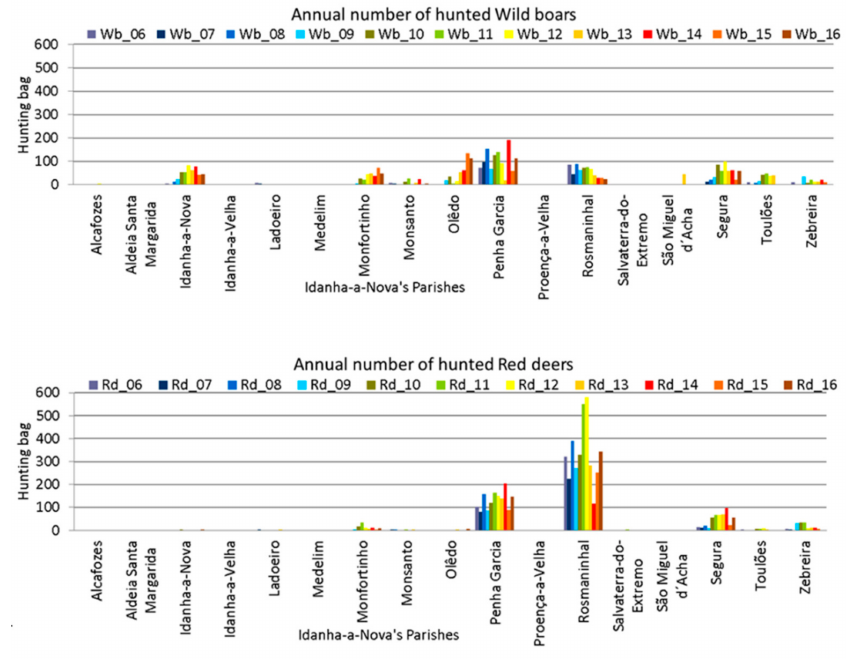
Figure 5. Hunting bag variation across Idanha-a-Nova’s parishes from 2006 to 2016. ( top ): wild boar; ( bottom ): red deer.